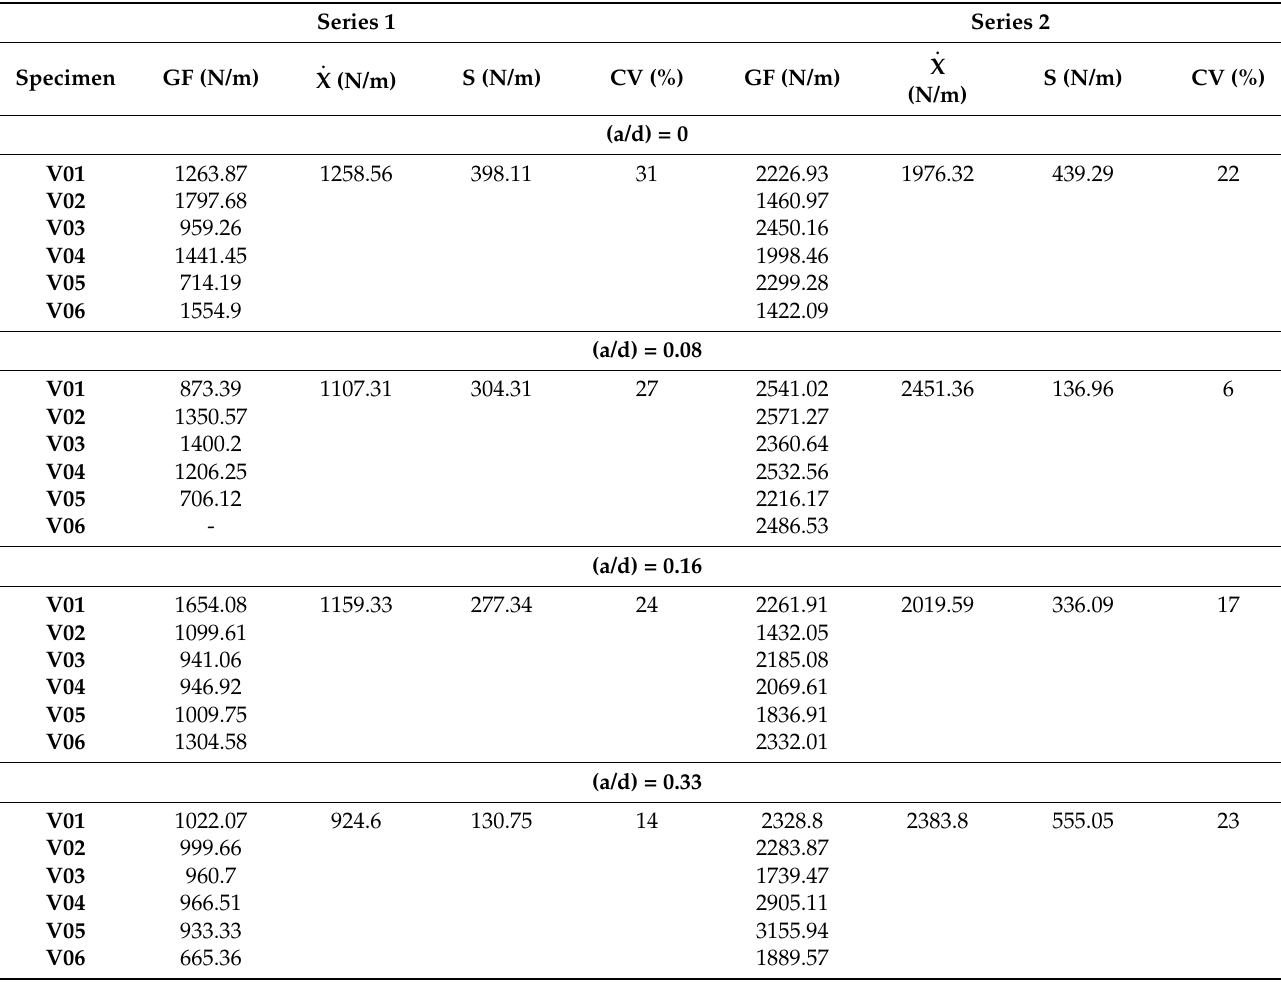
Table 5. Computed fracture energy with model 1 [47] for the specimens reinforced with fibers (Series 1 and Series 2). Series